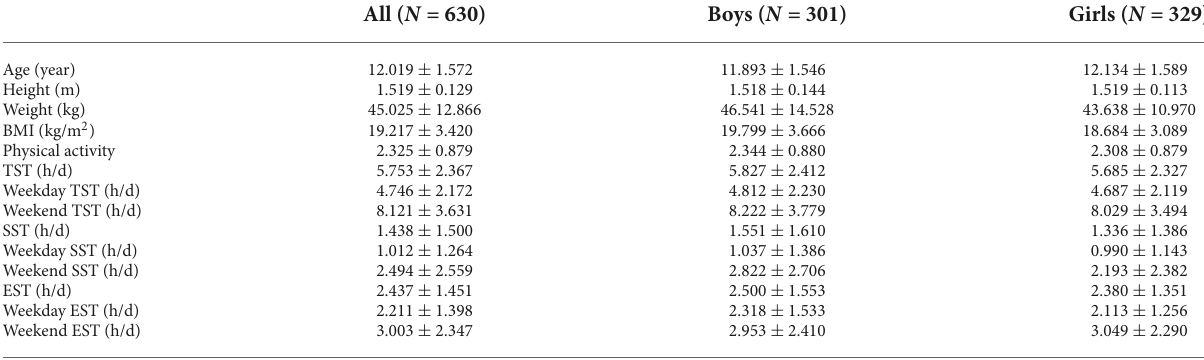
TABLE 1 The descriptive characteristics of the participants’ demographic and sedentary behaviors (Mean ± SD).